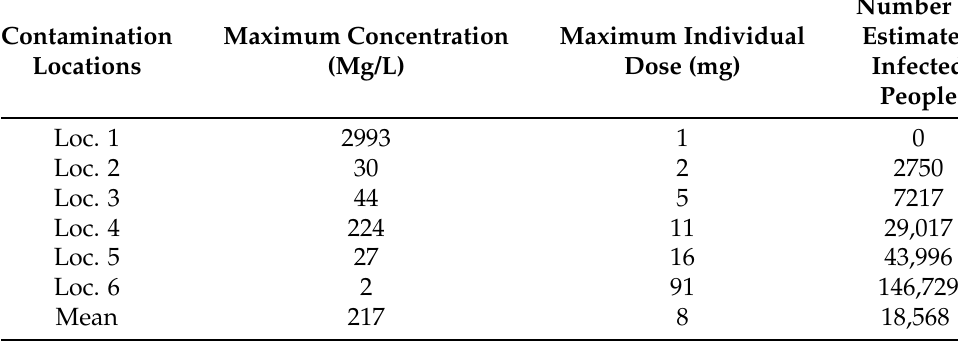
Table 2. Infected people based on contamination